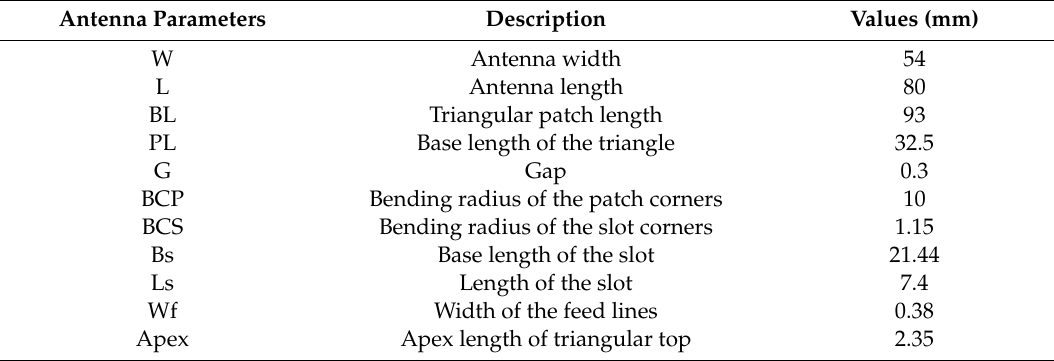
Figure 3. The geometry of the proposed broadband antenna. Table 5. The antenna and slot diminutions.